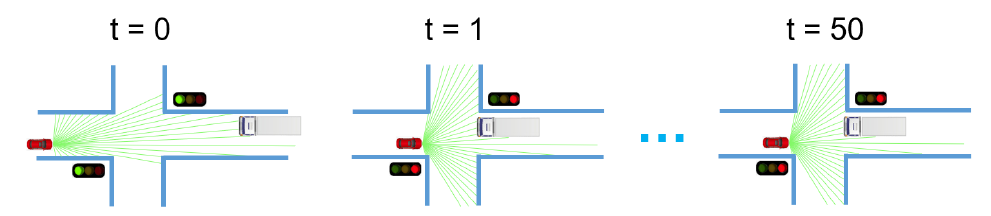
Figure 3. An illustrative example showing a SDV (red car) equipped with LiDAR observing an oncoming truck at time t = 0. The two cars stopped at an intersection and wait for the green light from t = 1 to t =